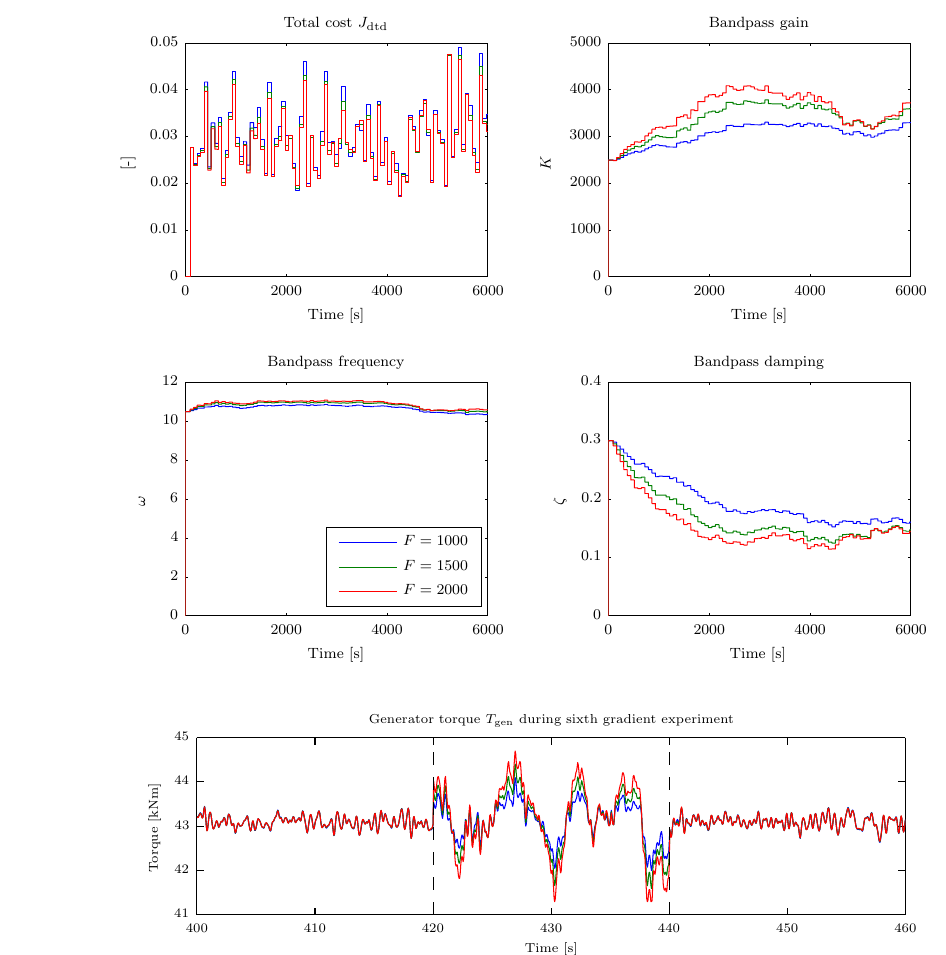
Figure 11. Comparison of three different signal-to-noise ratio scaling factors F . Results are shown for γ = 0 . 3, λ = 5 × 10 − 7 , and turbulent wind with mean speed 14ms − 1 and 10% turbulence